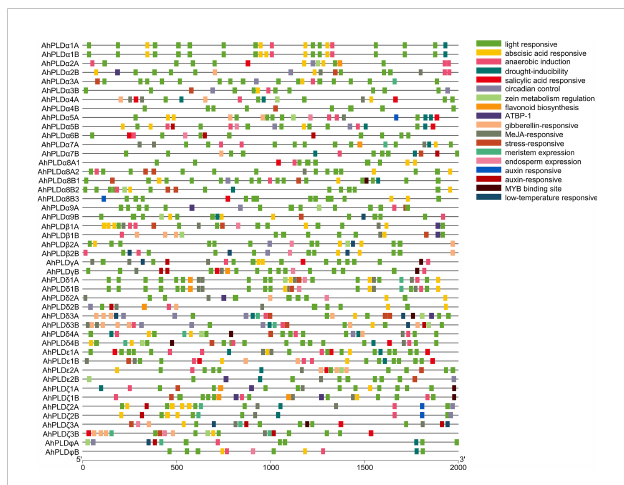
FIGURE 6 Cis -regulatory elements in the promoters of peanut PLD genes. Various cis -regulatory elements are displayed in different colored